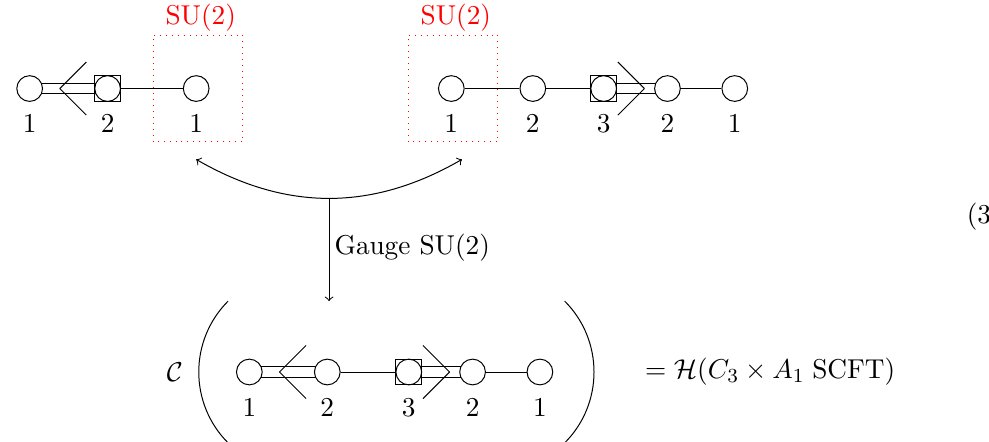
Table 5 . C 3 A 1 theory. Left : Hasse diagram for the Higgs branch of the 4 d (cid:2) theory. To the right of the Hasse diagram are the magnetic quivers for the closures of the leaves and to the left are magnetic quivers for the slices. Right : Hasse diagram for the full moduli space of the theory in 3 d = N